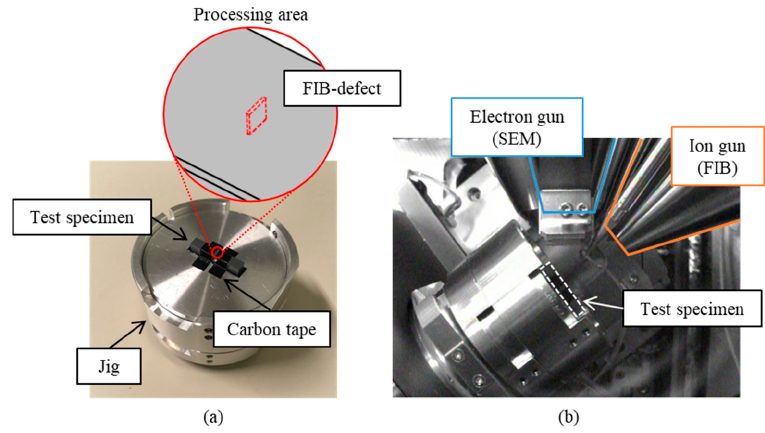
Figure 2. Photographs of the FIB process: ( a ) fixing method of test specimen; ( b ) inside of device.